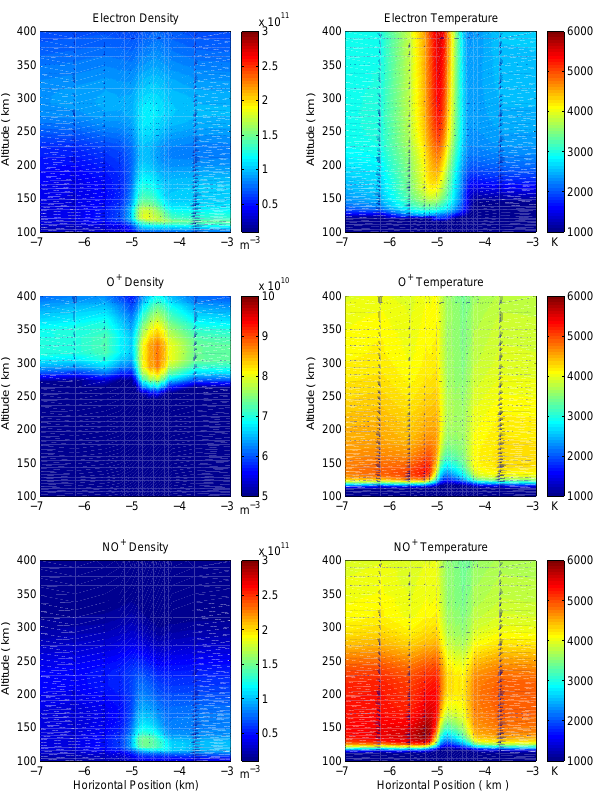
Fig. 4. ELECTRO output in the absence of E -region electron heat- ing by plasma waves and with the precipitation flux given in Fig.